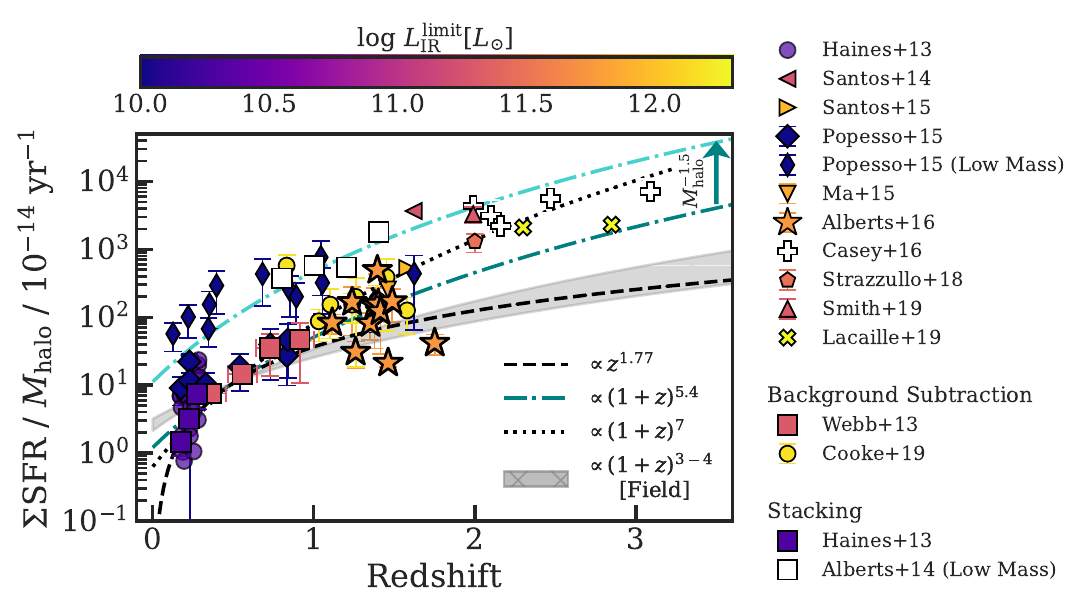
Figure 7. The halo mass-normalized total SFR from infrared observations of (proto-)clusters in the literature as a function of redshift. Colors indicate the reported limit in L IR for each study (white indicates that the limit was not available). Studies that use background subtraction rather than spec- z or photo- z cluster membership are indicated in the legend. Catalog or imaged stacked samples are shown as squares. All SFRs were converted to a Kroupa [153] IMF and the Kennicutt [478] conversion from L IR to SFR. The lines show different redshift evolution relations for Σ SFR/ M halo : ∝ z 1.77 (black dashed line; [378]); ∝ ( 1 + z ) 5.4 (dark teal dash-dot line; [197,467,479]); ∝ ( 1 + z ) 7 (black dotted line; [456,480,481]), normalized at z = 0.5. The general evolution for field galaxies ∝ ( 1 + z ) 3 − 4 [469–472] is shown in the gray region. The light teal dash-dot line shows the ∝ ( 1 + z ) 5.4 relation scaled from log M 200 / M (cid:12) = 14.5 → 14 following Σ SFR/ M halo ∝ M − 1.5 for